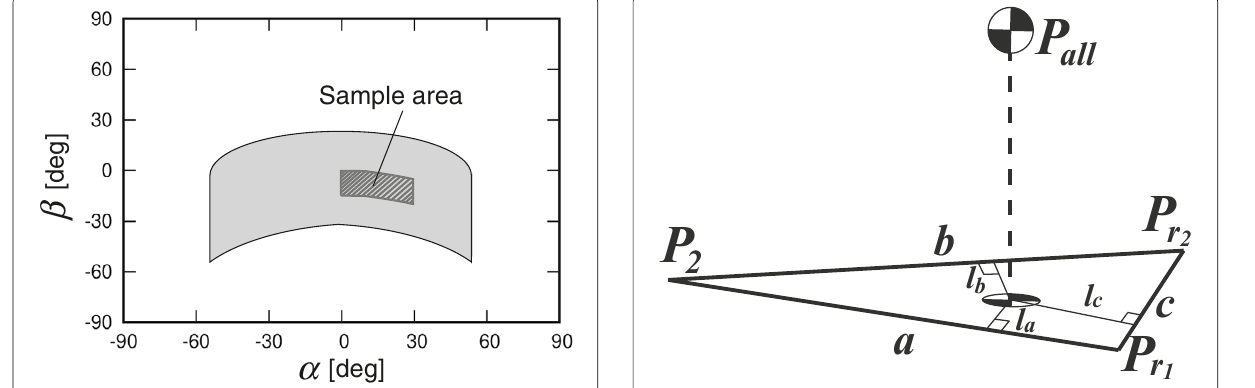
Fig. 15 The enlarged view of the sample area’s landing range